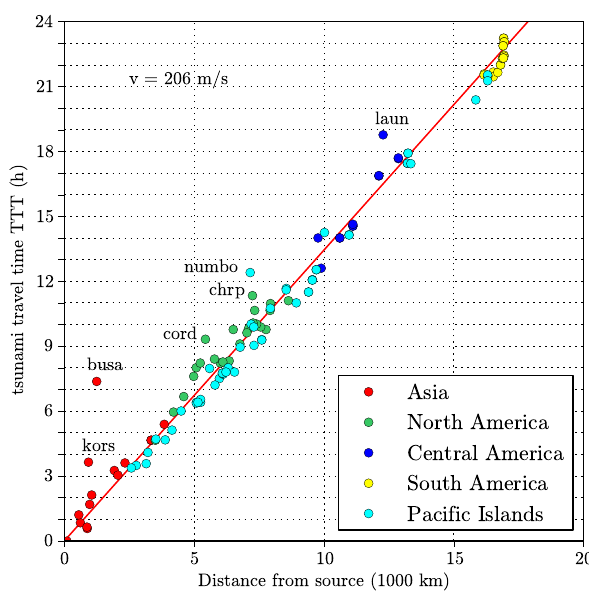
Fig. 2. Observed Tsunami Travel Times (TTT) plotted vs. distance between the tide-gauge station and the earthquake epicenter, taken at the position (38.297N, 142.372E) following USGS (see USGS website http://earthquake.usgs.gov/earthquakes/eqinthenews/2011/ usc0001xgp/). Distances have been computed using the Clarke earth ellipsoid (coded EPSG 7008). The fitting straight line (red) slope corresponds to the tsunami speed c = 206ms − 1 and the ocean depth d = 4330m ( c 2 = gd ). Most of the stations are quite close to the straight line. Only a few outliers are very much delayed. They are marked with the station code (see Table 1).